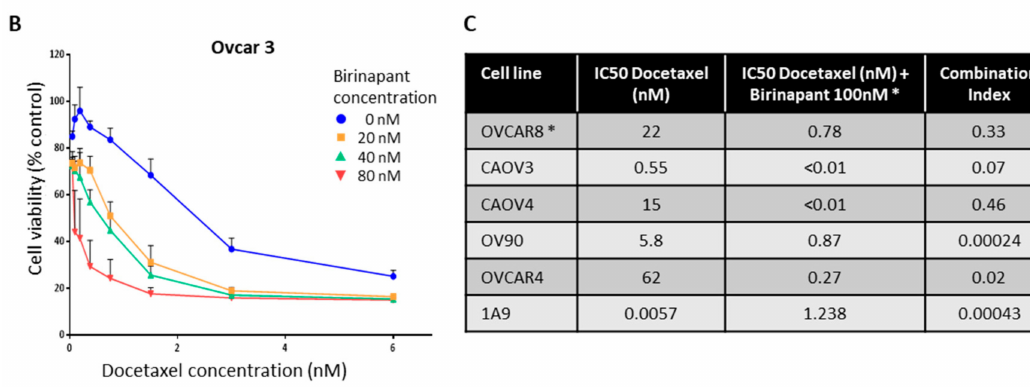
Figure 2. Birinapant is synergistic with docetaxel in vitro. ( A ) A panel of ovarian cancer cell lines was treated with increasing concentrations of single-agent birinapant ( left ) or docetaxel ( right ). ( B ) Cell viability of OVCAR3 cells was determined after treating with matrix titrations of birinapant and docetaxel. Shown are final values normalized as a percent of control (vehicle treatment). ( C ) IC50 values were calculated for docetaxel alone and for docetaxel when combined with birinapant (* 100 nM of docetaxel used for calculation of combination index in all cell lines except OVCAR 8 where 80 nM was used). The IC50 for birinapant alone was not included as all cell lines had minimal sensitivity to single-agent therapy. Error bars in ( A ) and ( B ) indicate standard error of the